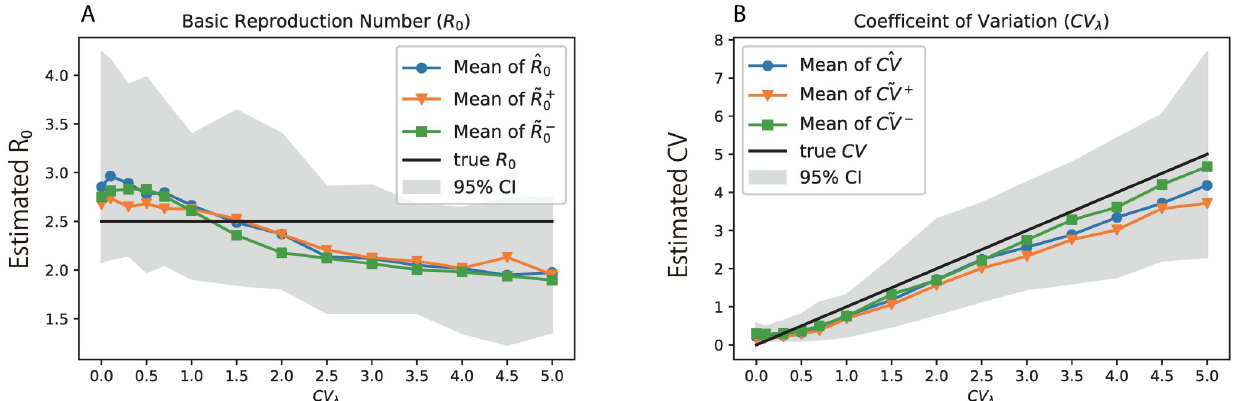
Fig 4. Performance of parameter estimation under finite population size and biased ρ SD . The estimates equipped with “hat” (e.g., ^ g ) are based on the infinite population size and the exact value of ρ . The estimates equipped with “tilde” (e.g., ~ g þ and ~ g (cid:0) ) are based on finite population size and 10% bias in SD ρ SD ( ~ g þ is on upwards bias and ~ g (cid:0) is with downwards bias in ρ SD ). The colored curves in (A) and (B) are the mean of 200 simulations, while the shaded areas denote the 95% confidence intervals based on these simulation replicates.